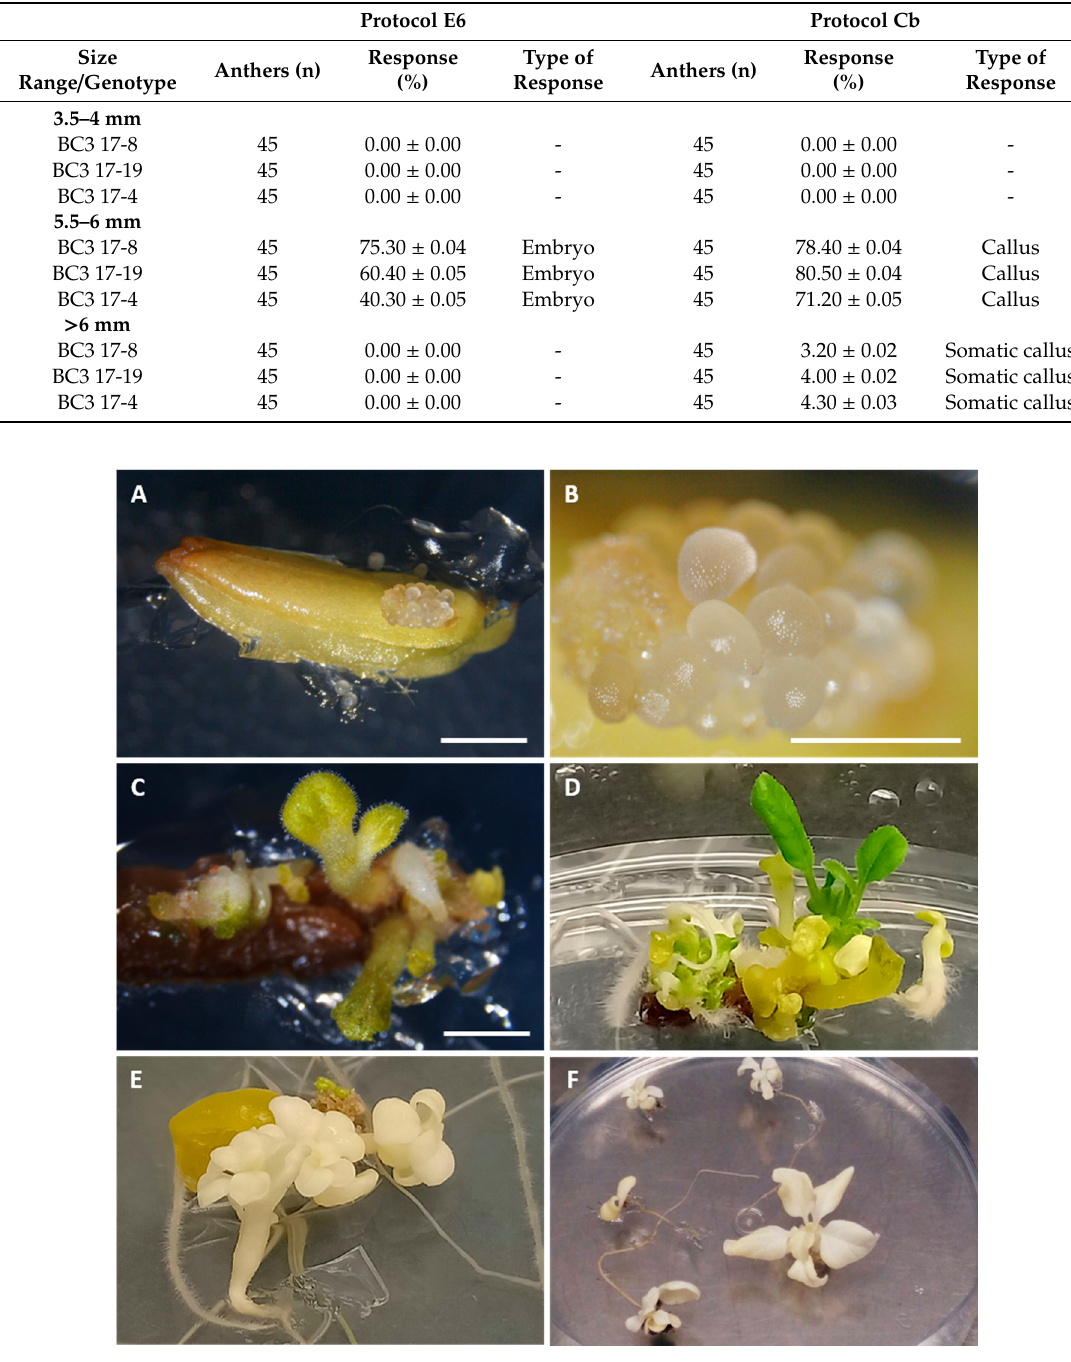
Figure 6 . Anther selected through Microscan grown in E6 medium four days after being placed in culture ( A ); detail of the same anther, the formation of globular-type embryogenic structures can be observed ( B ); anther cultivated in E6 medium after one month of culture, it can be seen how embryogenic structures evolve giving rise to torpedo embryo-like structures and in some cases cotyledonal stage ( C ); fully developed seedlings and cotyledonal embryos of eggplant after one and a half months of culture in E6 medium ( D ); albino eggplant embryos from anther culture in E6 medium ( E ); albino embryos isolated from the anthers and subcultured in E0 base medium ( F ). The size of the bars is 1